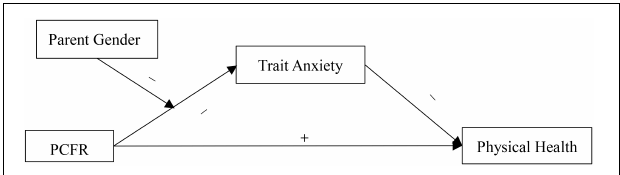
FIGURE 1 | The effect of perceived parent-child facial resemblance (PCFR) on parental physical health: a moderated mediation